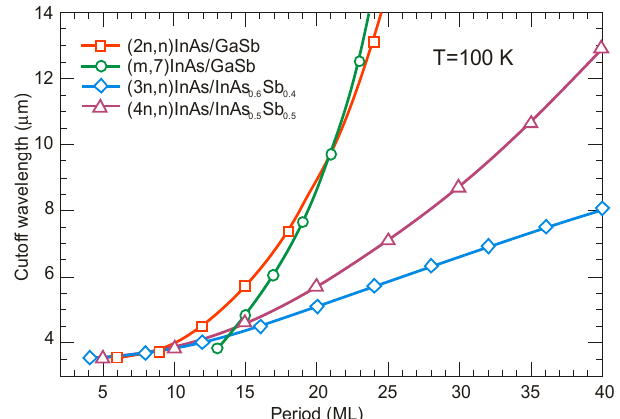
Figure 25. Theoretically estimated λ cut-off for (2n,n)InAs/GaSb, (m,7)InAs/GaSb, (3n,n)InAs/InAs 0.6 Sb 0.4 ,